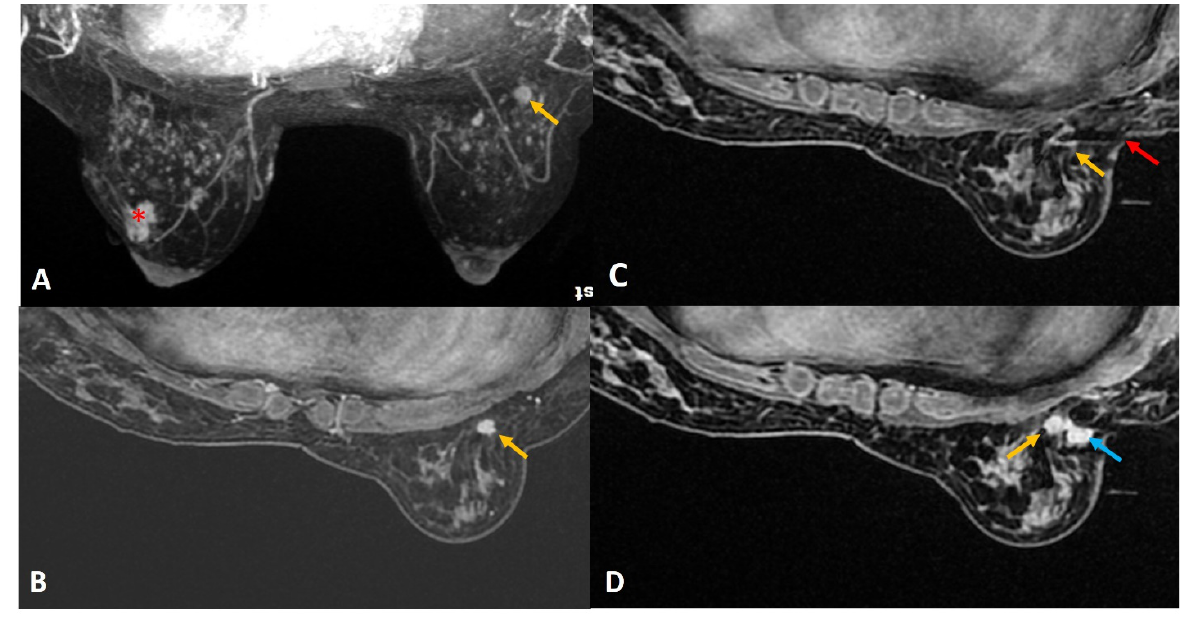
Figure 12. ( A ). MIP image from staging scan of a woman with diagnosed left breast cancer (red asterisk) showed indeterminate lesion in the right breast (yellow arrow). ( B ). In absence of definite sonographic correlate, MRI-guided biopsy was arranged. The target was noted outside the grid compression (yellow arrow). ( C ). A free-hand direct insertion of the guide shows the tip of the obturator (red arrow) exactly within the target lesion (yellow arrow). The histology returned as normal breast tissue that was considered discordant. ( D ). Retrospective review of the post biopsy image showed the target lesion (yellow arrow) along the medial aspect of the hematoma